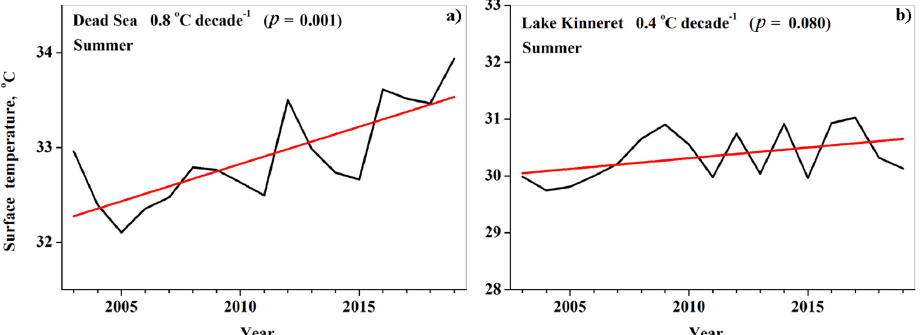
Figure 14. Comparison between ( a ) the Dead Sea and ( b ) Lake Kinneret of year-to-year variations of MODIS/Terra surface water temperature in the summer season (June–August), during the 17-year period (2003–2019). The straight red lines designate linear fits.